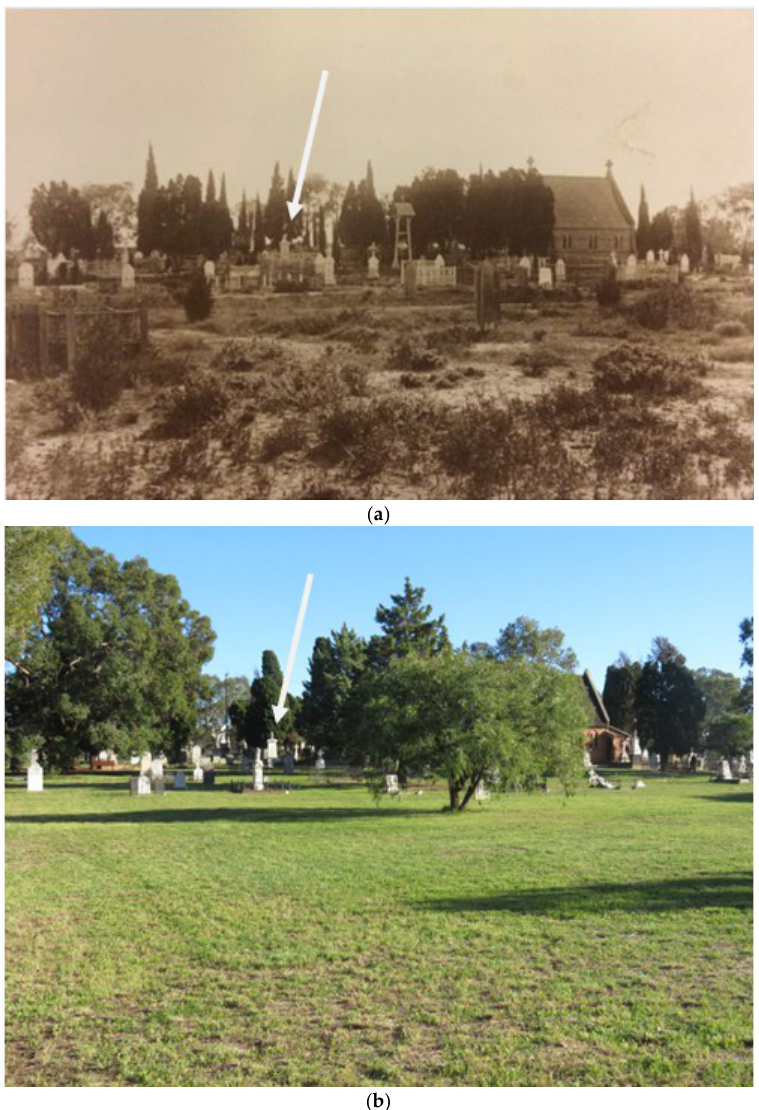
Figure 4 . The East Perth Anglican–General Cemetery, looking west from soil graves (foreground and middle ground) toward the brick and vault section (background), and St Bartholomew’s Church. The arrow to the Chipper headstone (d.1886; NT#509) noted in both photographs is for positional reference: ( a ) Photograph from approximately 1890s (#25024P in the State Library of Western Australia 1 ). The entire area was by then used for burials. Note the uneven ground where burial mounds are apparent; the use of funereal cypress trees; the wooden headboard in the middle ground; and post and rail fences around graves now absent from the cemetery; ( b ) Approximately the same view in 2017 with the same lack of monuments for burials in the soil graves (foreground and middle ground); note St Bartholomew’s chapel (now a church) lost its Latin cross finials on the roof when it was extended in the 1900s. Photograph by Sandra Hayward